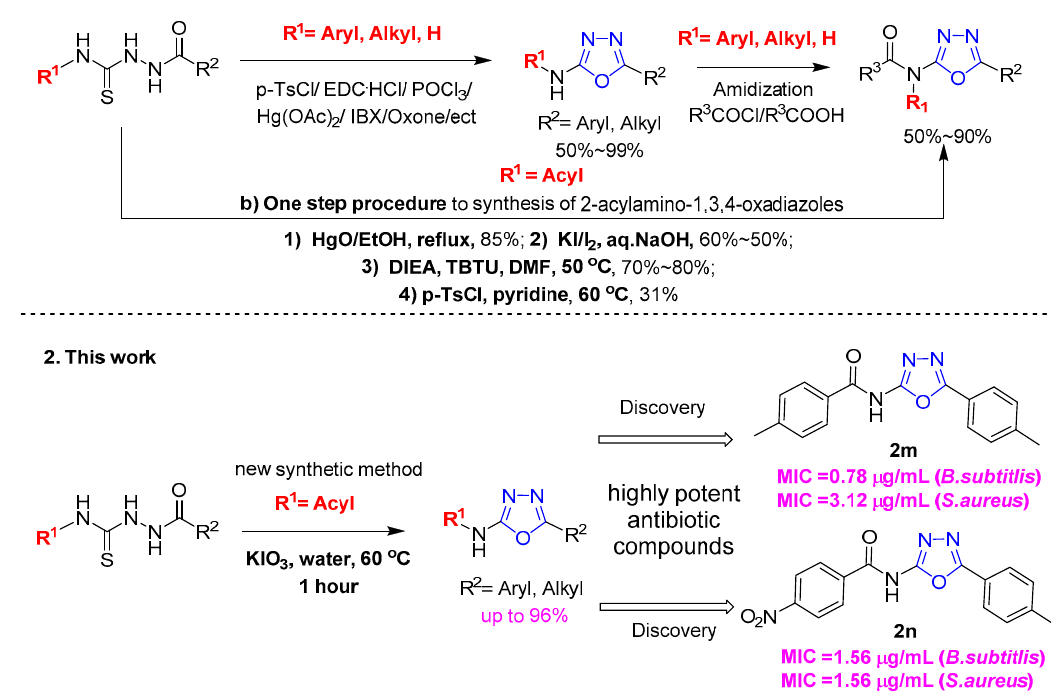
Scheme 1. Intramolecular cyclodesulfurization of thiosemicarbazides. 1 . The previous methods for